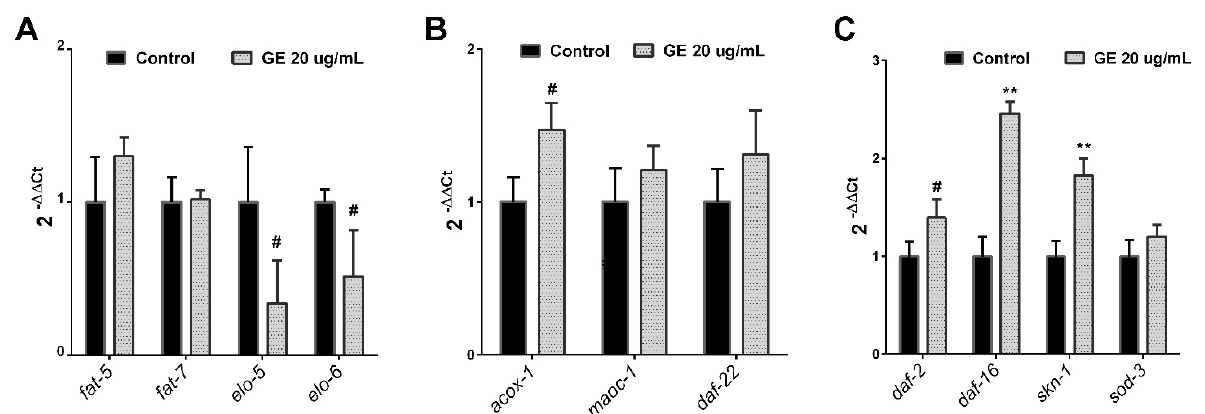
Figure 3. Gene expression levels of lipogenesis-related genes ( A ), β -oxidation-related genes ( B ), and daf-2/daf-16 and skn-1/nrf-2 signalling pathways ( C ). Results are expressed as the fold difference expression levels of each gene in GE-treated worms compared with the control, calculated with the 2 - ∆∆ Ct method. Significance refers to the effect of GE with respect to untreated control worms (ANOVA followed by LSD comparisons, # p < 0.1; *** p < 0.01).